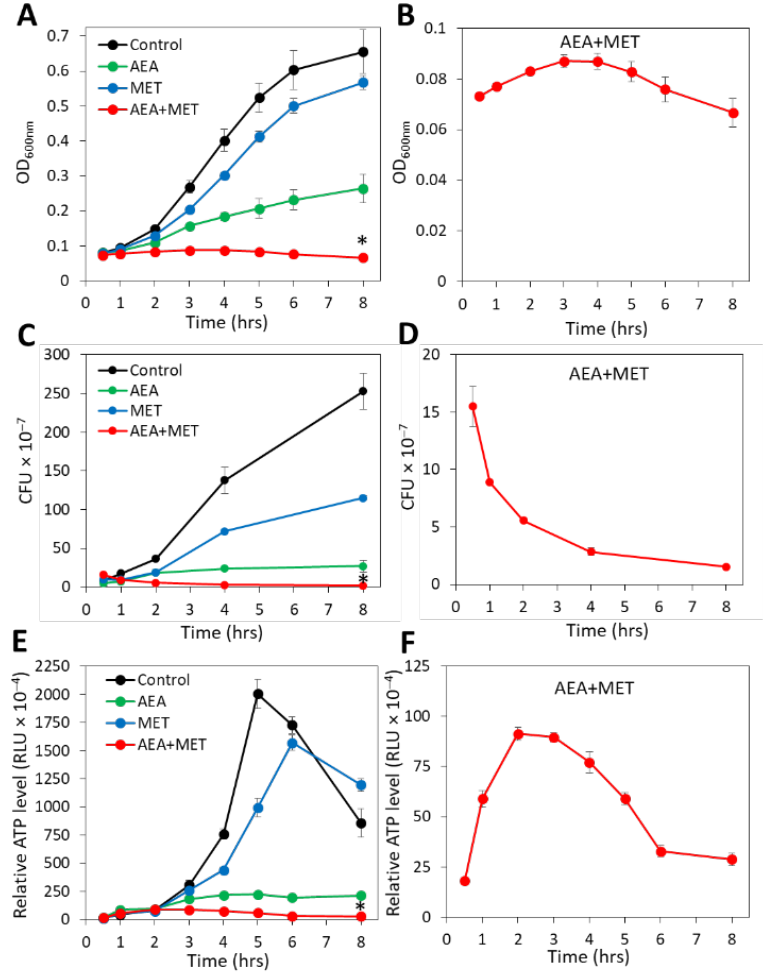
Figure 1. The combined treatment of AEA with methicillin (MET) caused a reduction in the CFUs with a concomitant transient increase in the ATP content. MDRSA CI-M were exposed to 50 µ g/mL AEA and/or 50 µ g/mL MET or equal ethanol concentrations that served as controls. The samples performed in triplicates were analyzed in parallel for changes in turbidity (OD at 600 nm). ( A , B ), colony forming units (CFUs) ( C , D ) and ATP content ( E , F ). ( A , C , E ) show the four treatment groups together, while the scale of the Y-axis in B, D, and F was adjusted to visualize the changes in the combined AEA/MET treatment group. * p < 0.05 when comparing the AEA + MET with either compound alone. RLU = Relative Luminescence